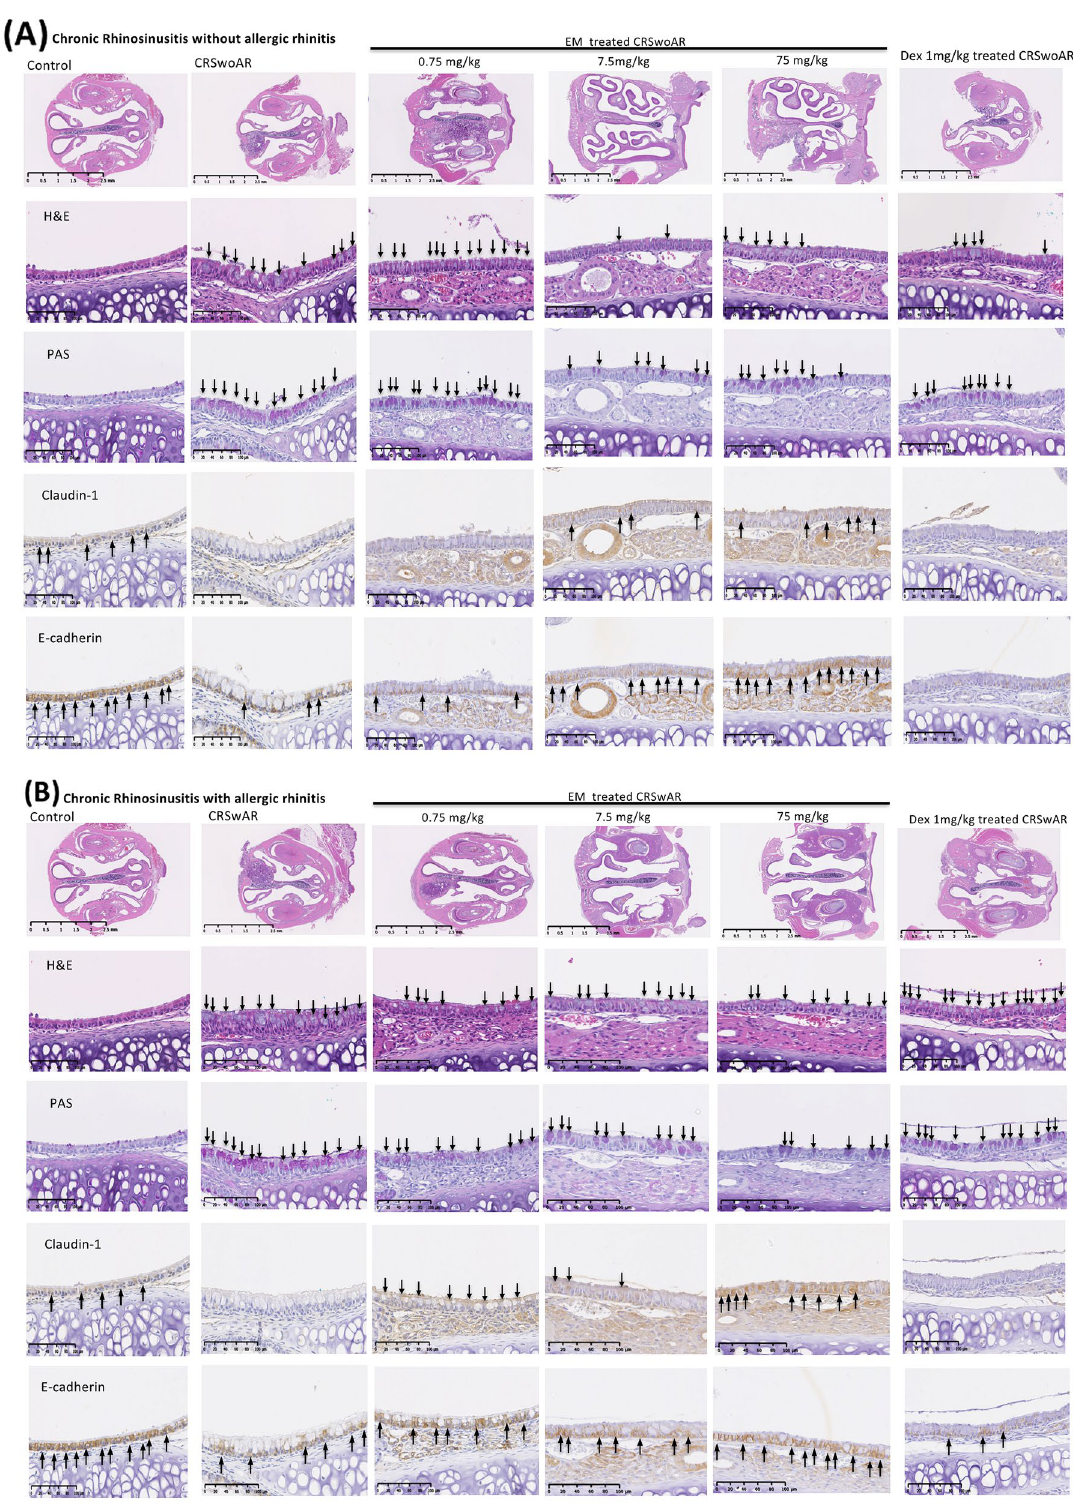
Figure 3. Representative images showing histological features of nasal tissues in ( A ) chronic rhinosinusitis mice without allergic rhinitis and ( B ) chronic rhinosinusitis mice with allergic rhinitis. Increased number of goblet cells, increased mucus production, decreased claudin-1 and e-cadherin staining are found in tissue sections of CRSwoAR and CRSwAR. Control: without rhinosinusitis; CRSwoAR: chronic rhinosinusitis without allergic rhinitis; CRSwAR: chronic rhinosinusitis with allergic rhinitis; EM: erythromycin; Dex: dexamethasone; H&E: hematoxylin and eosin staining; PAS: periodic acid-Schiff staining. Arrow heads mark the eosinophils; arrows mark the representative goblet cells, PAS staining, e-cadherin and claudin-1 staining